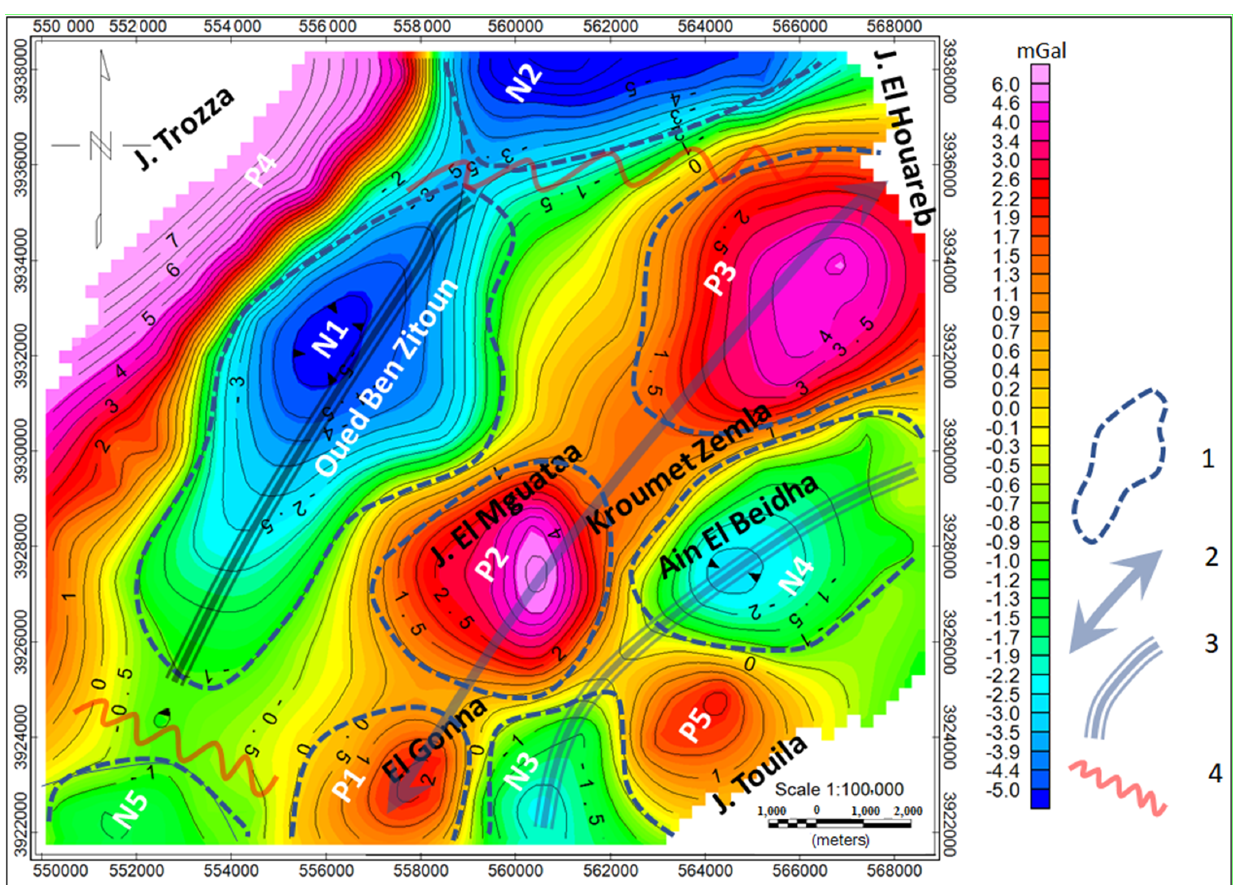
Figure 5. Interpreted residual gravity map of the Ain El Beidha plain. (1) Limits of major gravity anomalies. (2) Major positive gravity anomaly axis. (3) Major negative gravity anomaly axis. (4) Northern and southern limits of the Ain El Beidha plain.